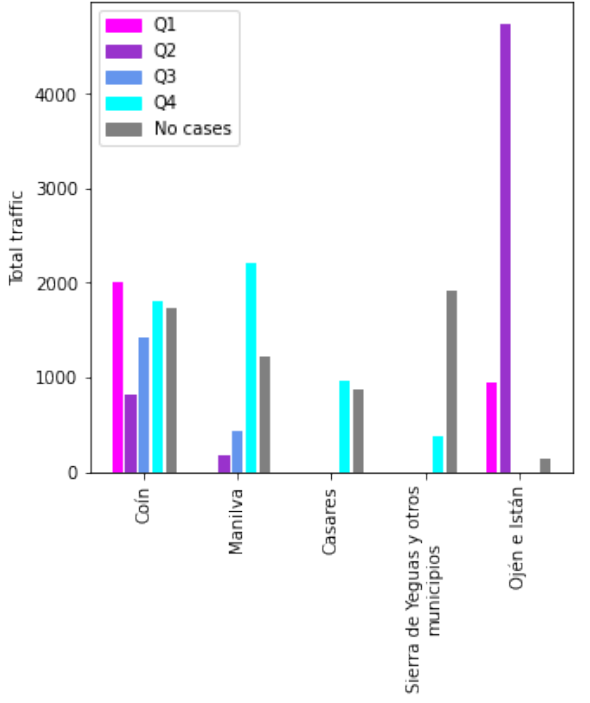
Figure 8. Traffic profiles for anomalous cells of the class with no